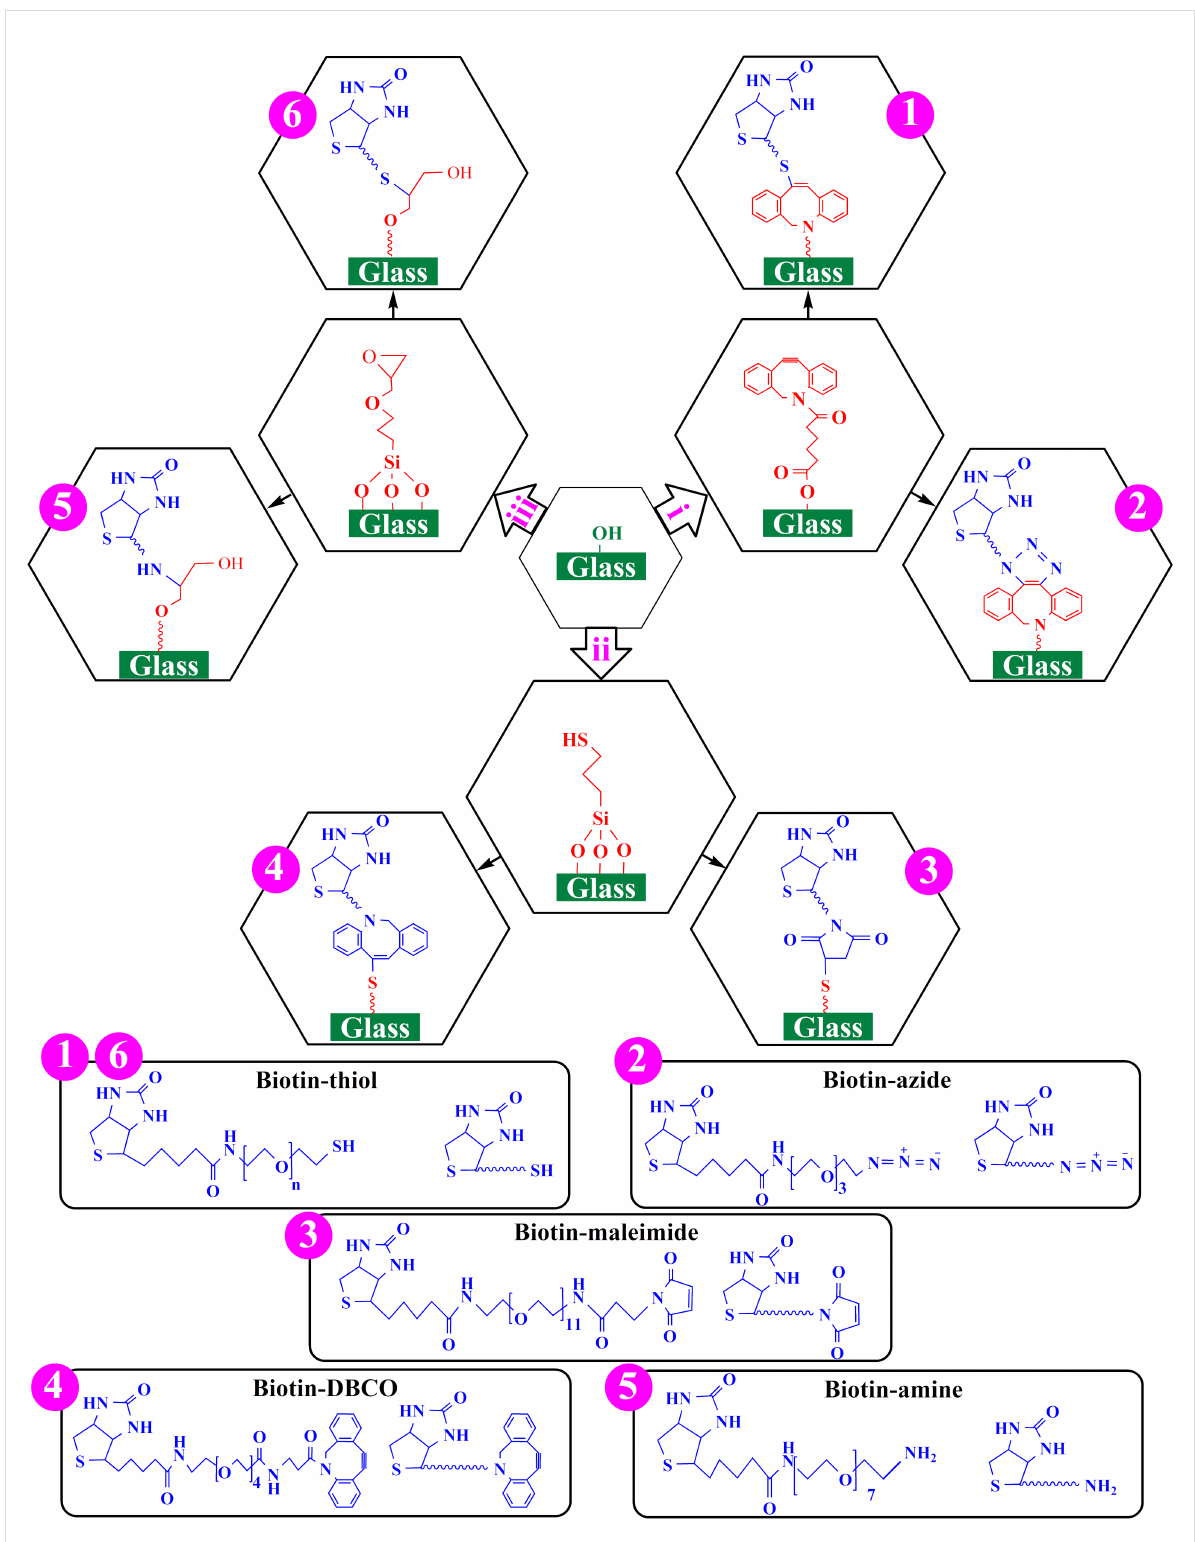
Figure 1: Biotin immobilization on the hydroxy-terminated glasses via different click reactions. Hydroxy-terminated glasses were first functionalized with DBCO–OH (path i), (3-mercaptopropyl)trimethoxysilane (MPTMS) (path ii) or (3-glycidyloxypropyl)trimethoxysilane (GPTMS) (path iii) and subse- quently biotinylated through different click reactions (routes